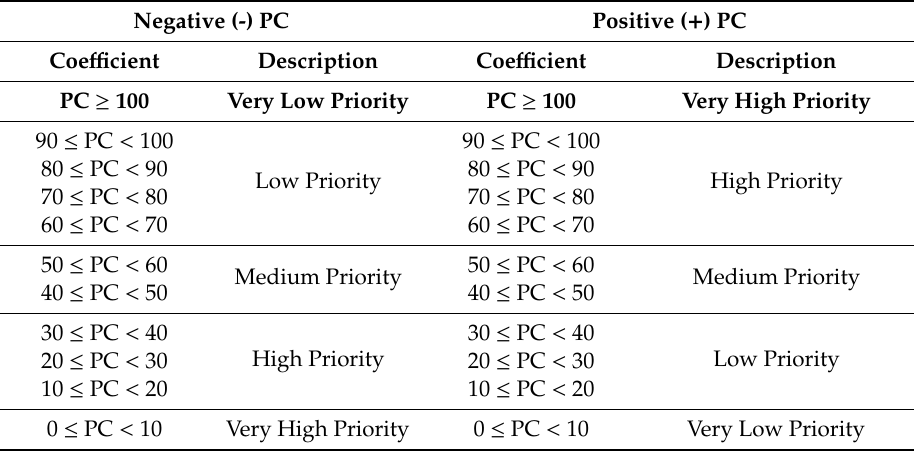
Figure 16. Prioritization coefficients in the ‘RC110’ group for BHI thresholds (50, 75, and 90). Table 8. Prioritization coe ffi cients (PC)